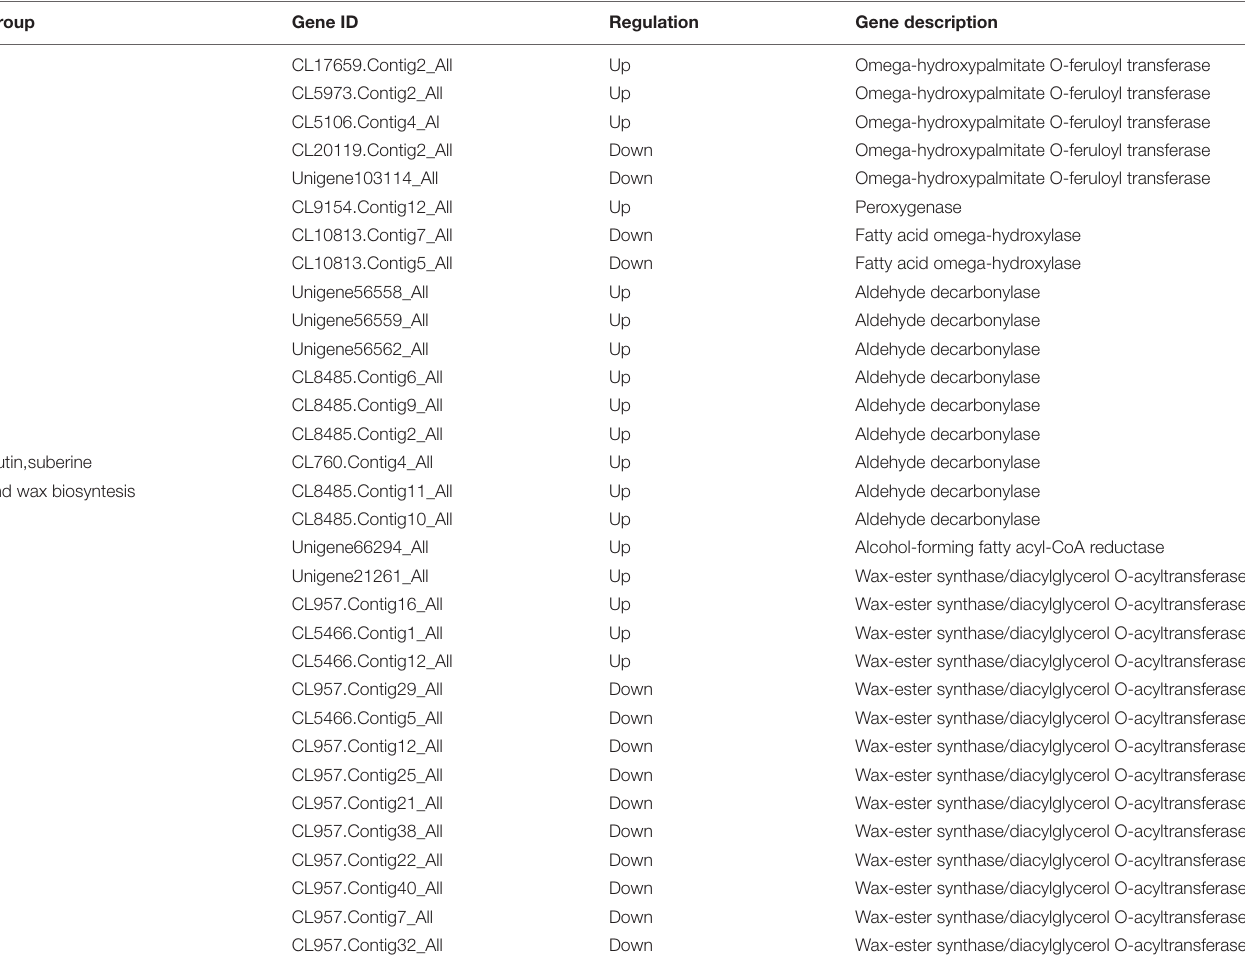
TABLE 5 | DEGs associated with cutin, suberine and wax biosynthesis.